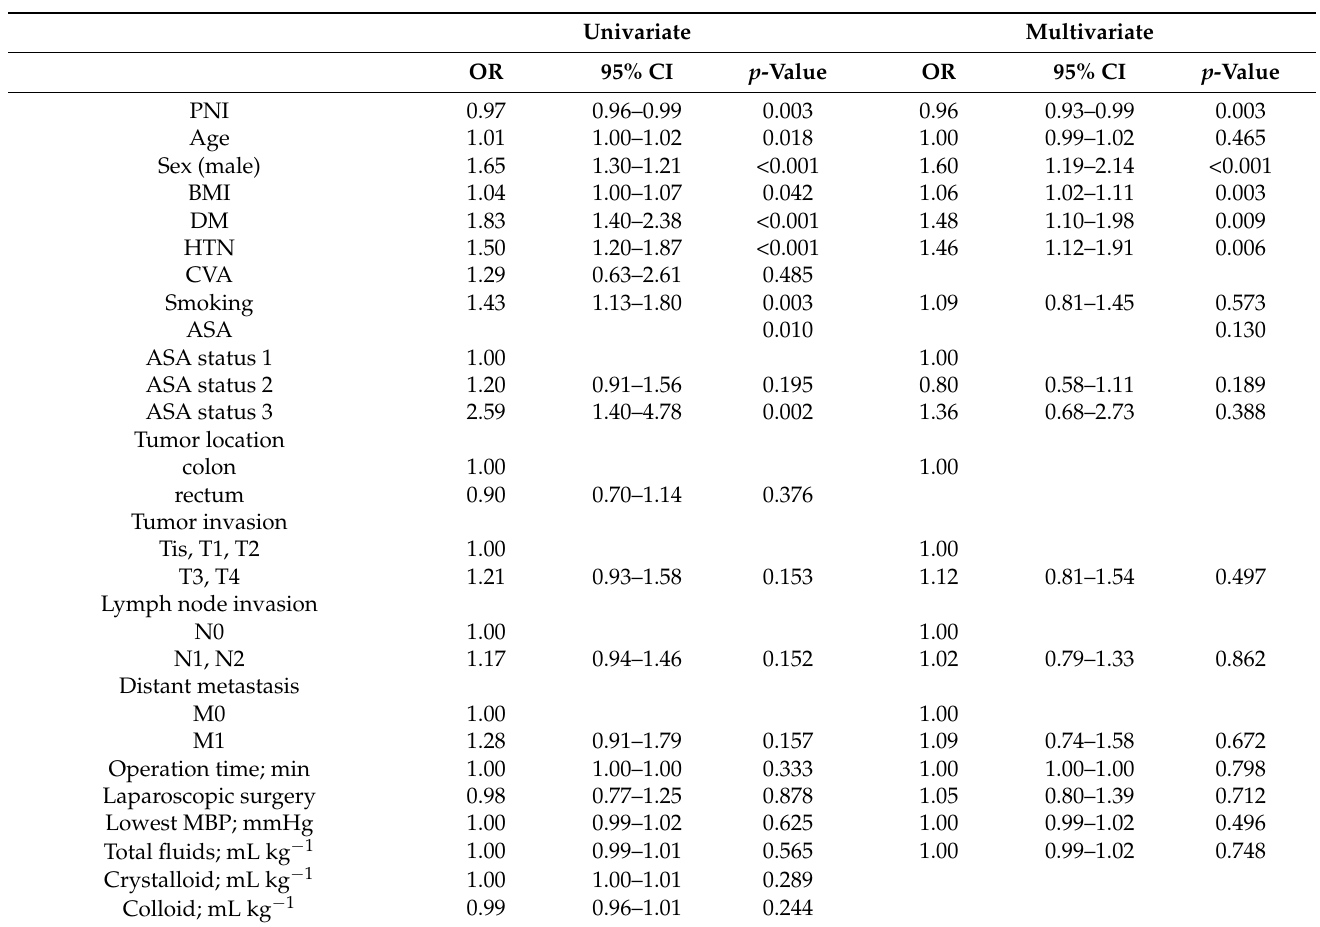
Table 2. Univariate and multivariate logistic regression analysis of AKI. Univariate